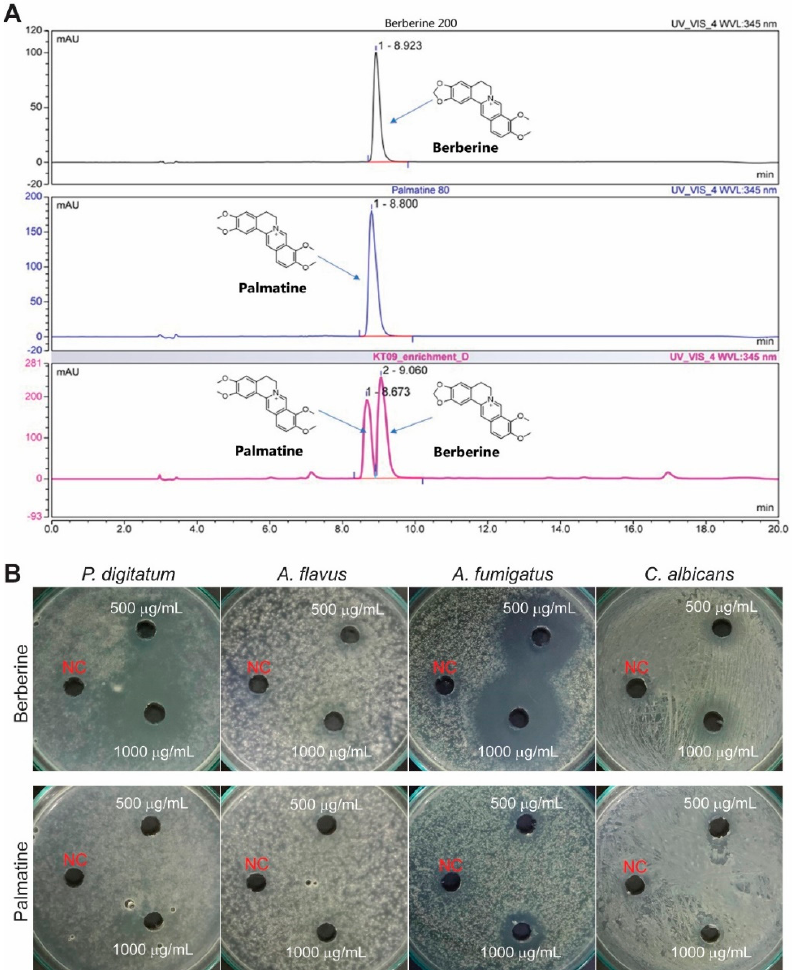
Figure 4. Analysis of the major metabolites of the M. bealei ethanolic extract. ( A ) Absorption peaks of berberine and palmatine were detected at 345 nm by HPLC using the standard compounds and alkaloid enrichment. ( B ) Evaluation of the antifungal activity of berberine and palmatine purified from the enrichment extract. These compounds were examined for their antagonistic ability against four different fungi using the agar well diffusion method. Purified berberine and palmatine at concentrations of 500–1000 µg/mL were used for the tests. DMSO (10%) was used for the negative control (NC). Plates were incubated at 25–30 °C for 1–3 days.